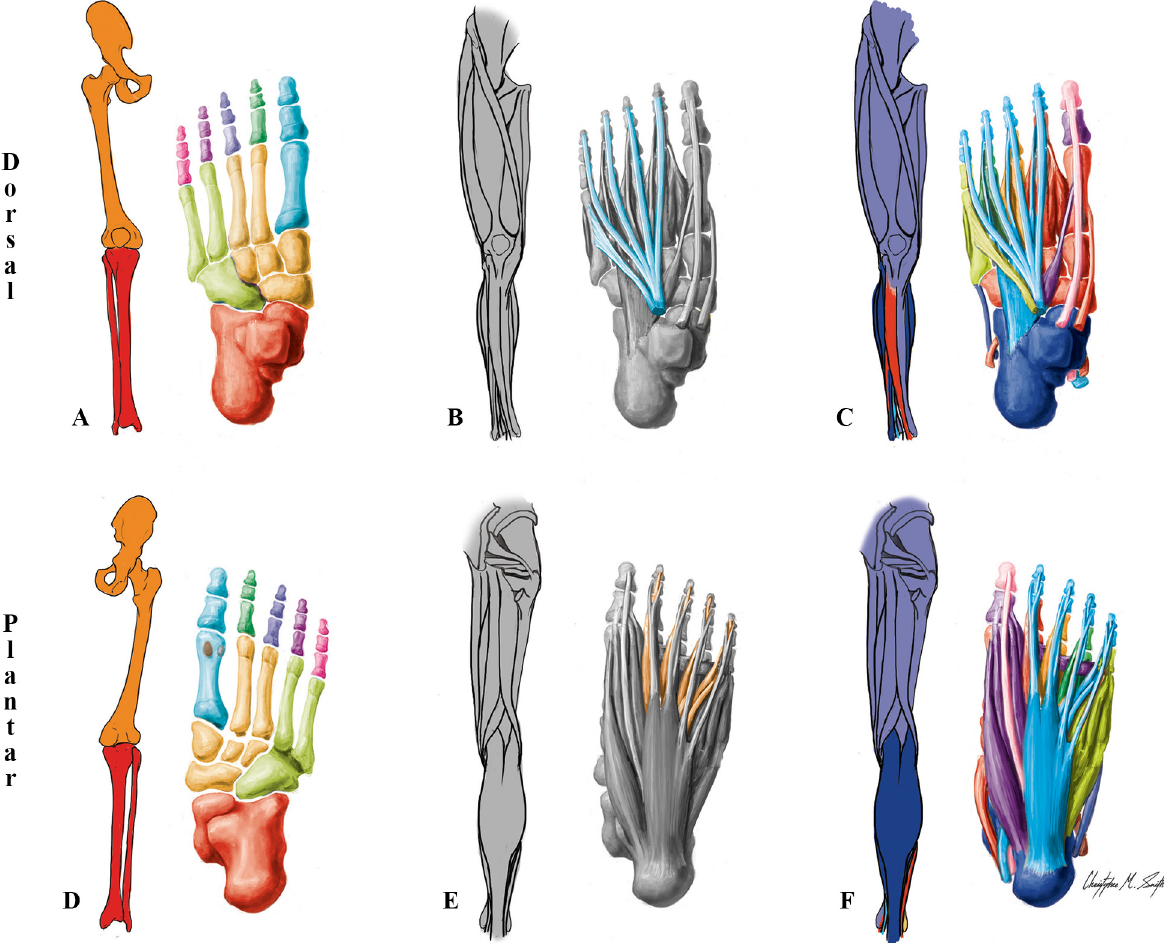
Fig 3. Modules of the normal adult left LL identified using AnNA. A to C dorsal (extensor) view; D to F ventral (flexor) view. It should be noted that the skeletal, muscular and musculoskeletal networks and modules of this left normal adult LL are similar to the right one. A, D) Skeletal network modules: in light green , the cuboid/ metarsals 4 – 5 module; in pink , purple , dark blue and dark green , the digit 5, 4, 3 and 2 modules; in turquoise , the digit 1/metatarsal 1 module; in red , the leg/proximal ankle module; in light orange , the tarsals/metatarsals 2 – 3 module; in dark orange , the girdle/thigh module; in grey , the lateral sesamoid and medial sesamoid modules. B, E) Muscle network modules: in turquoise , the extensor longus/fibularis module; in orange , the flexor longus/ plantae/lumbrical module. C, F) Musculoskeletal network modules: in turquoise , the long flexor/extensor toes module; in red , the ankle/digit 2 movement module; in magenta , the hip-thigh-leg movement module; in dark blue , the ankle movement module; in purple , the big toe movement module; in orange , the digit 3 movement module; in dark green , the digit 4 movement module; in light green , the digit 5 movement module; in pink , the distal phalanx digit 1 movement